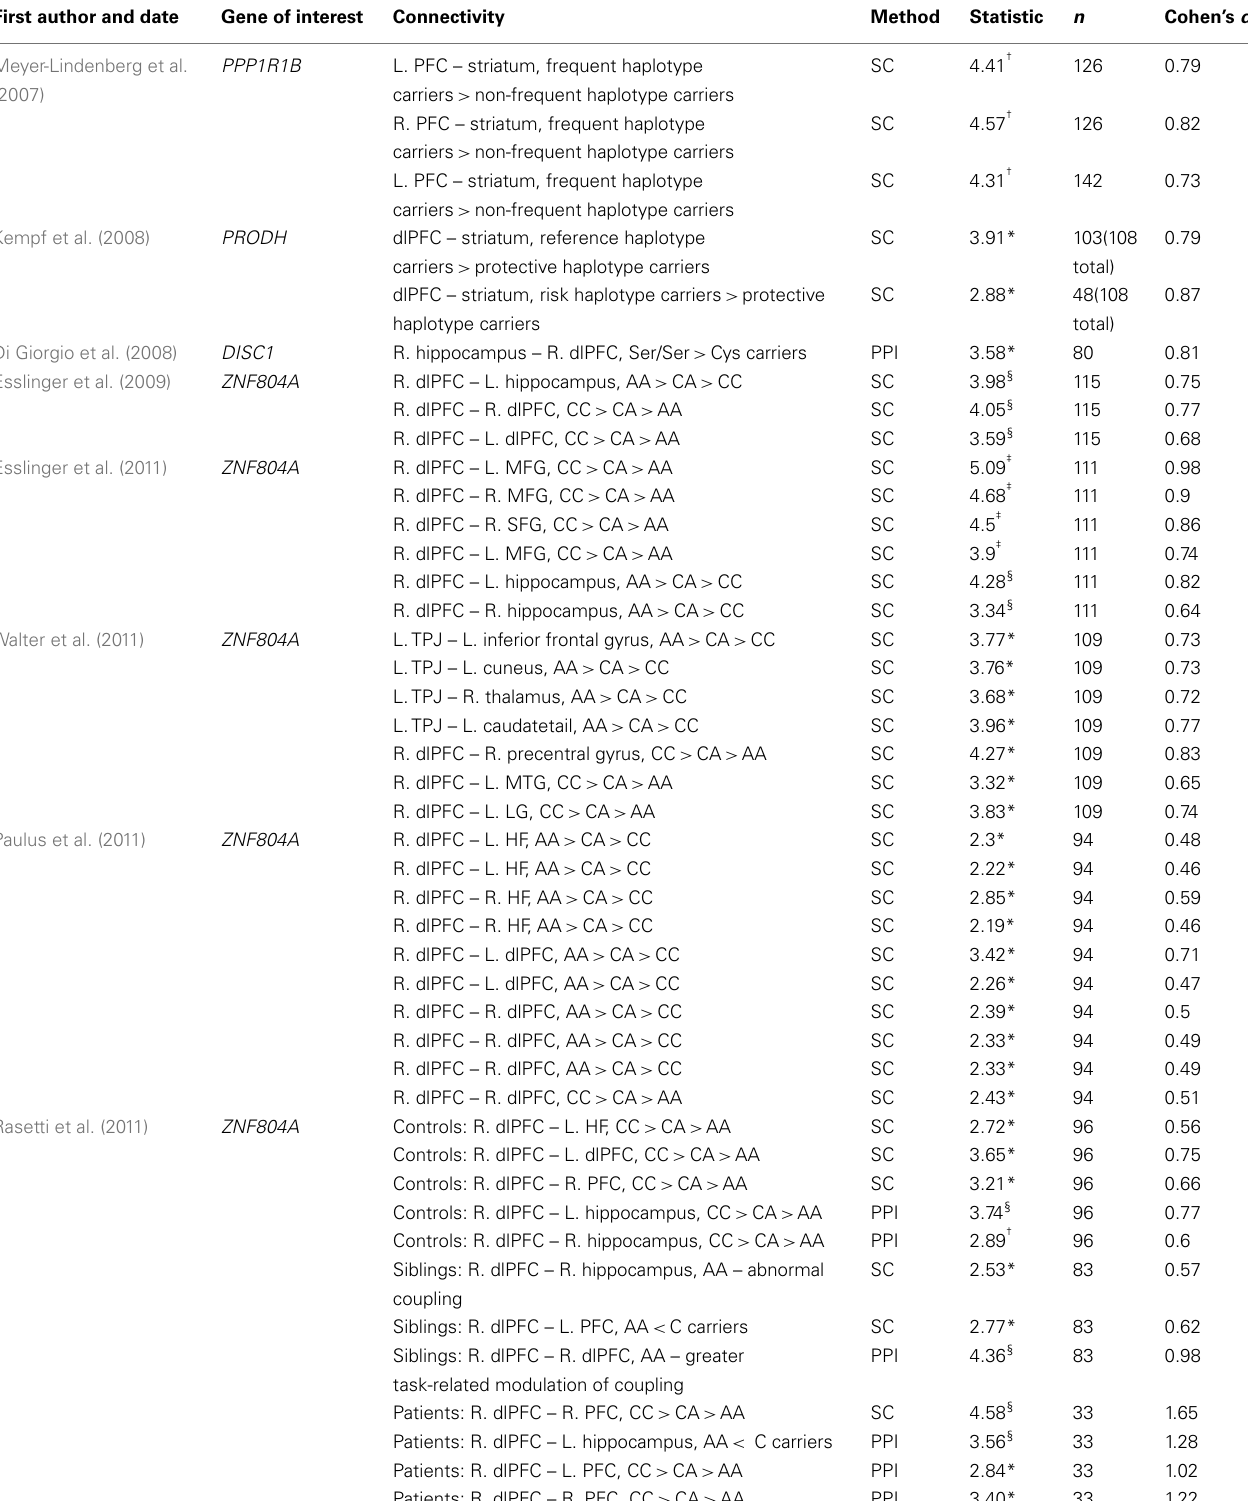
Table 1 | Details of the functional connectivity studies included in this